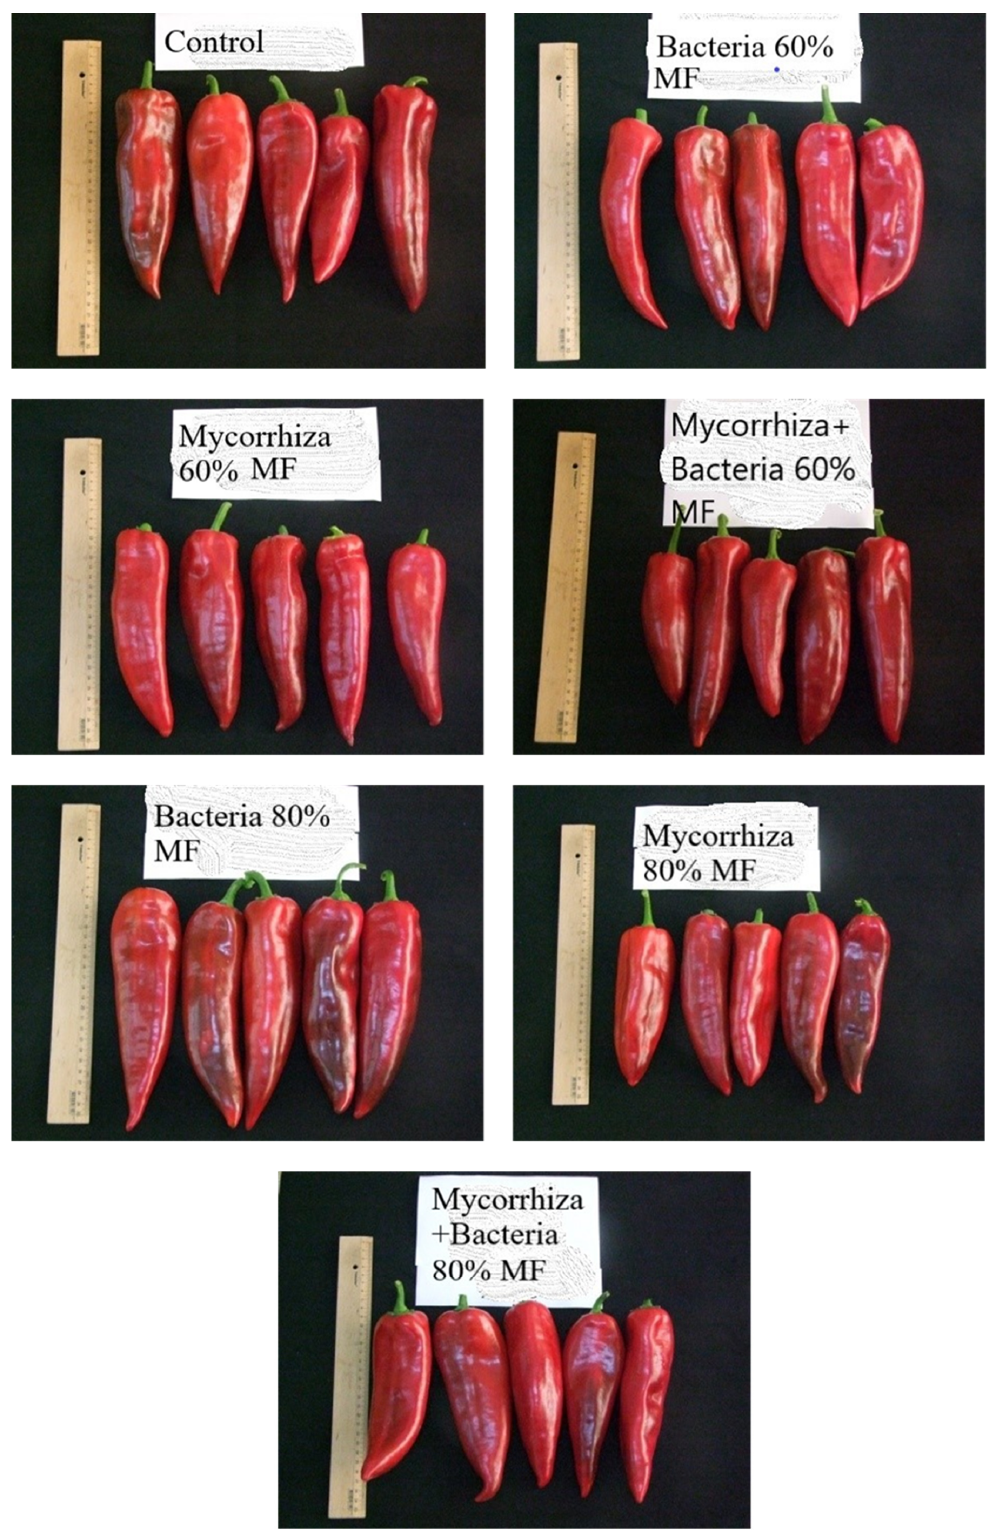
Figure 1. Soilless-grown capia peppers were harvested weekly when they reached the red maturity stage. MF: mineral